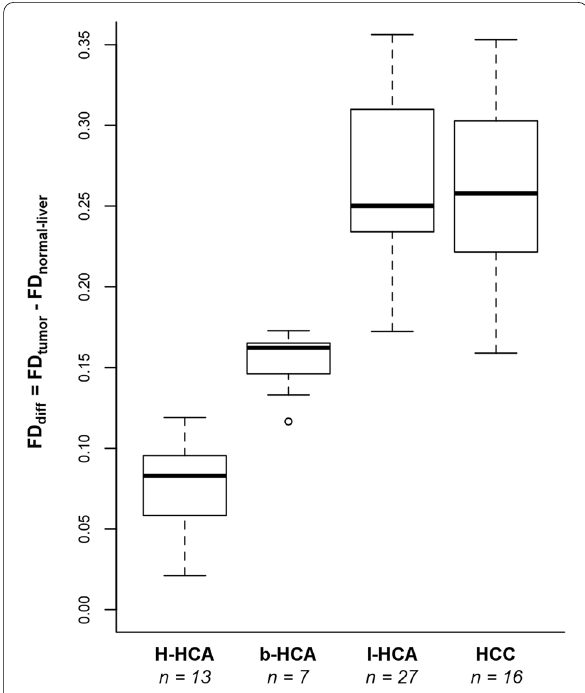
Fig. 6 Global fractal dimension differences (FD diff FD tumor FD normal-liver ) by tumor entity. All group comparisons = − were significant ( p < 0.001) except for inflammatory adenomas